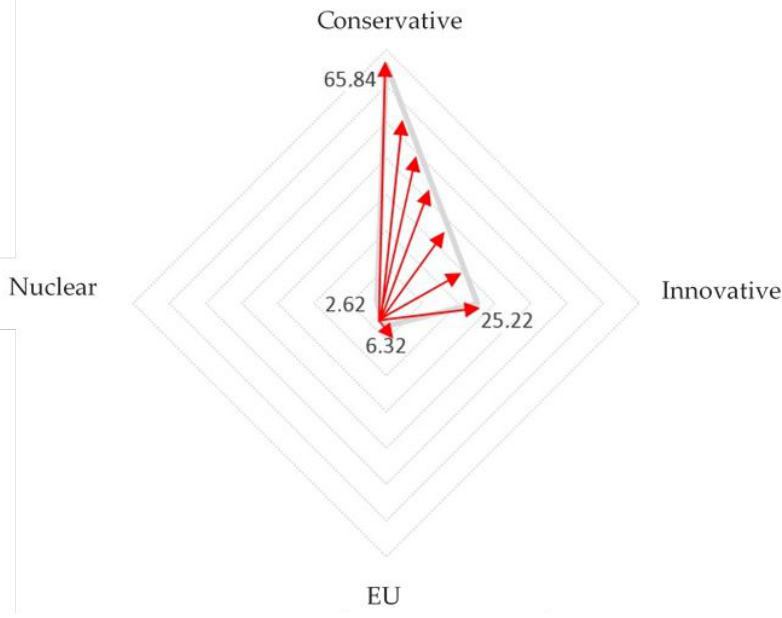
Figure 6. Directions of development of the national power sector according to the results of the